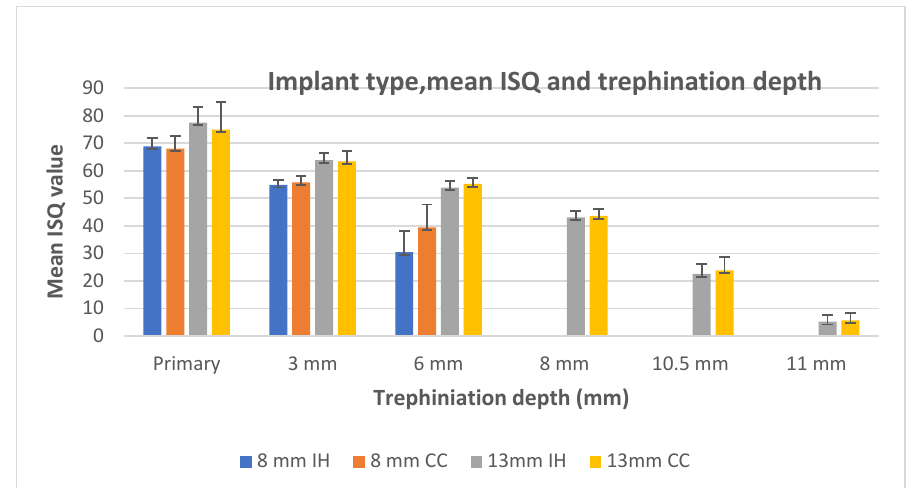
Figure 2. Implant type, mean ISQ, and trephination depth. There was a significant difference in the ISQs between the 8 mm and 13 mm implants ( t = 2.921, p = 0.004), with a mean difference of 9.45. However, the t-test showed no significant difference in the ISQs between the implant designs ( t = 0.531, p = 0.596). Therefore the two implant designs were united. Figure 3 showed the ISQ at each trephination depth in the unified group; in general, there was a negative linear correlation between the trephination depth and the ISQ (r = −0.916, p < 0.001) .